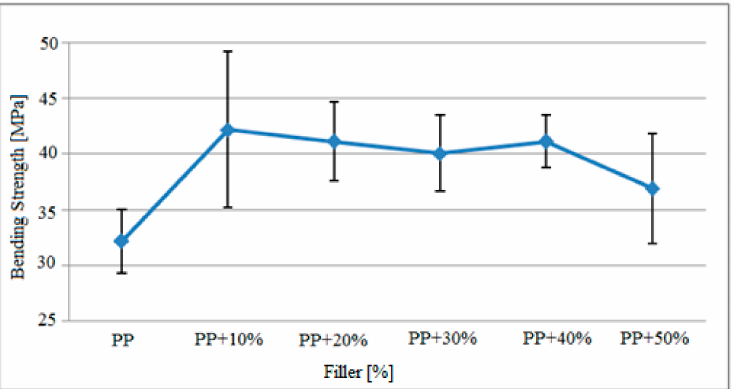
Figure 7. Variation in the bending strength of polypropylene matrix samples after gamma radiation based on the filler